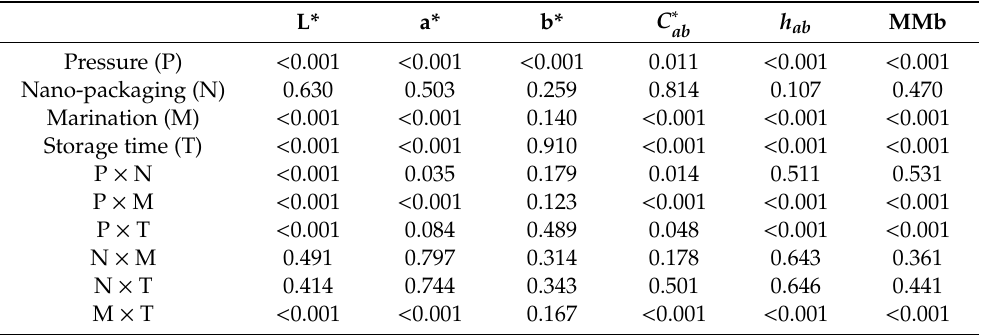
Table 1. The p -values of the e ff ects of the studied factors (pressure application, packaging type, marination and storage time) on beef color